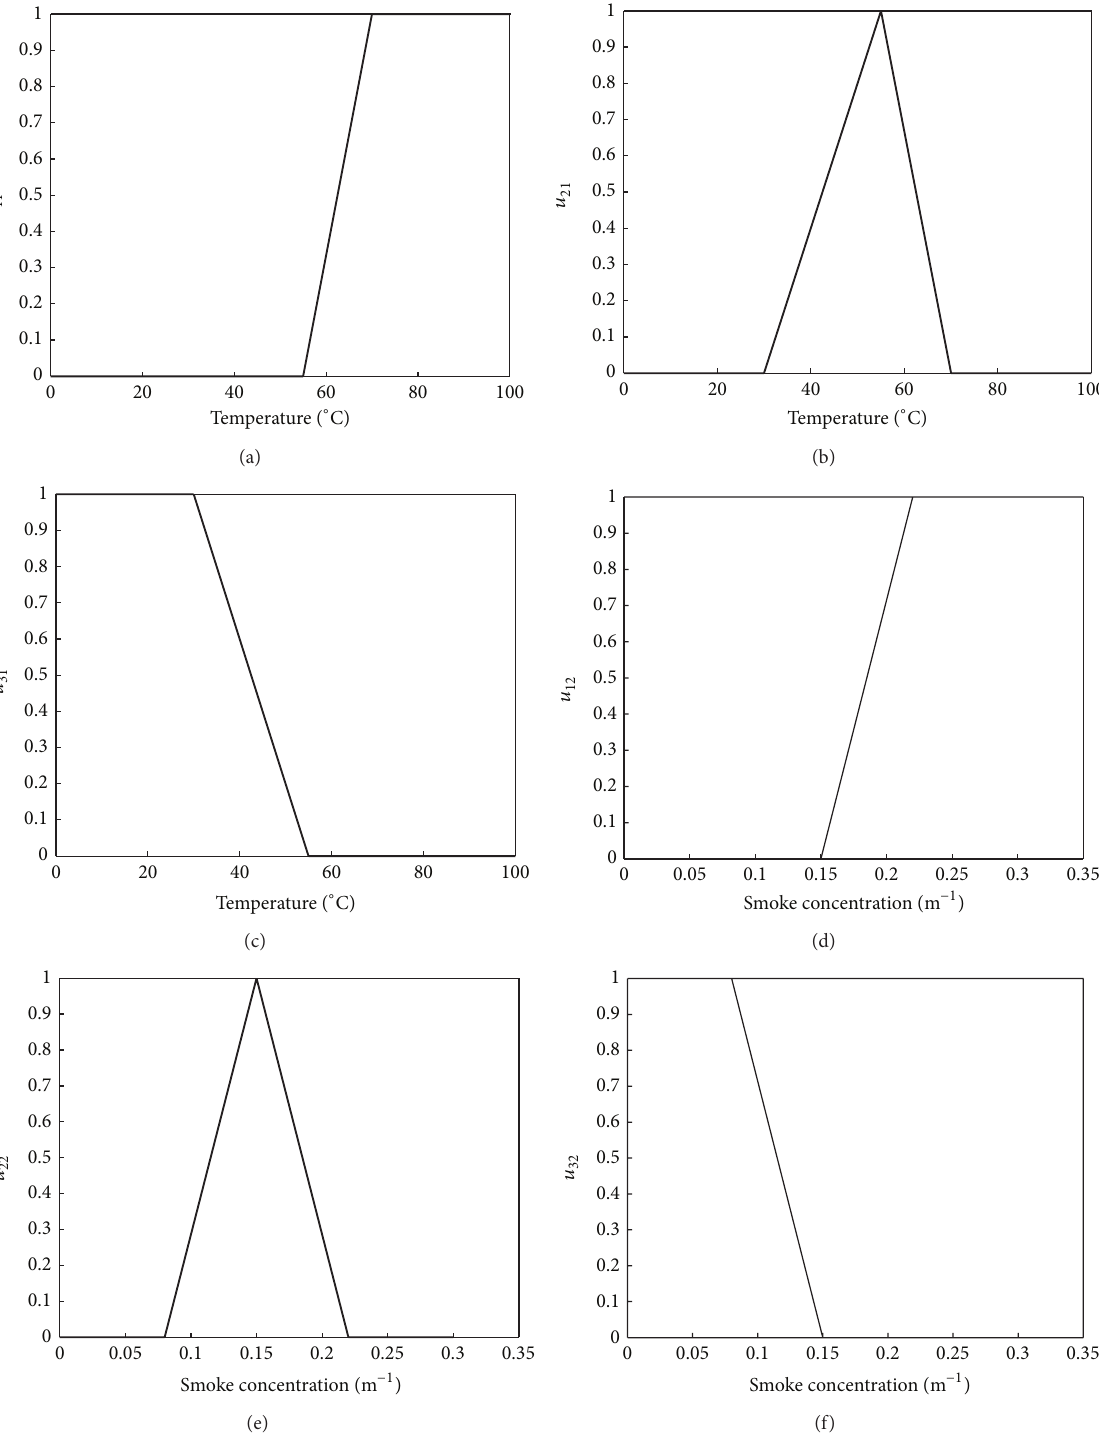
Figure 13: Membership functions of attributes corresponding to